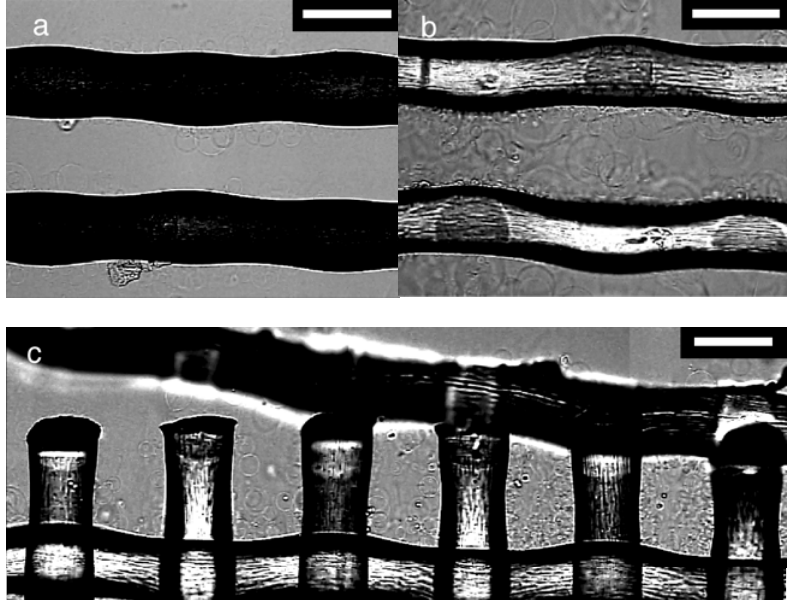
Figure 4. (a) Electroswelling on a pair of two parallel threads taken from a PET mesh #145 with sinusoidal ac voltage (5.0 Vpp, 2 Hz) at 90 min; (b) A pair of two parallel threads from a nylon mesh #145 at 100 min; (c) Electroswelling at a partially broken edge of a nylon mesh #145 at 100 min. The picture is a composite of three frames separately taken. Bar = 100